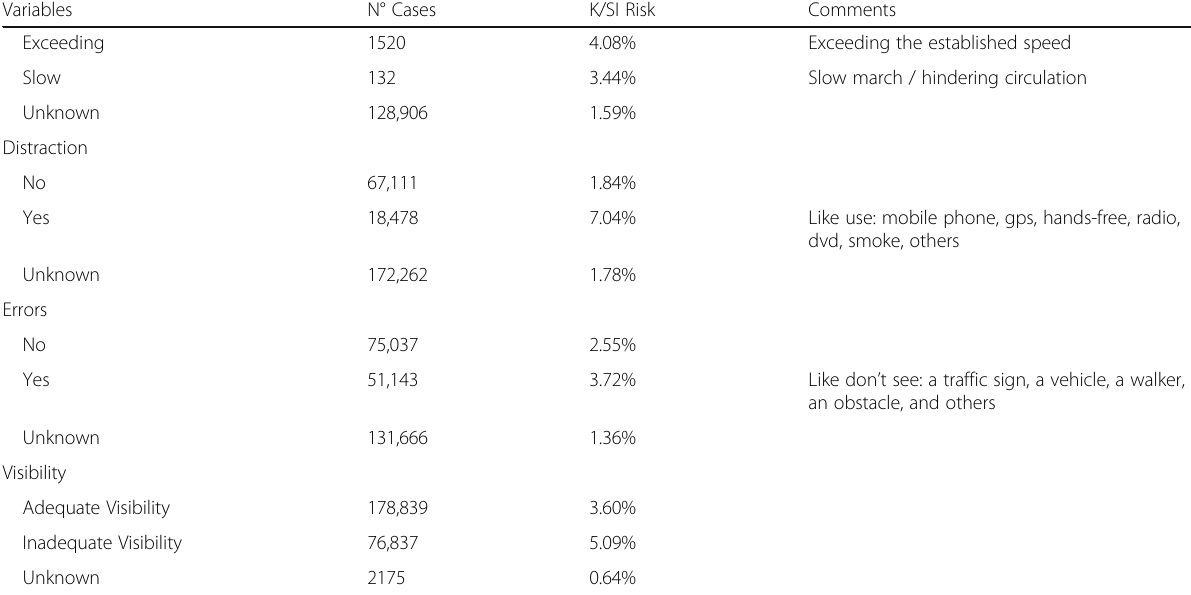
Table 3 A priori probability of the severity of the injury. Processed by the Authors (Continued)